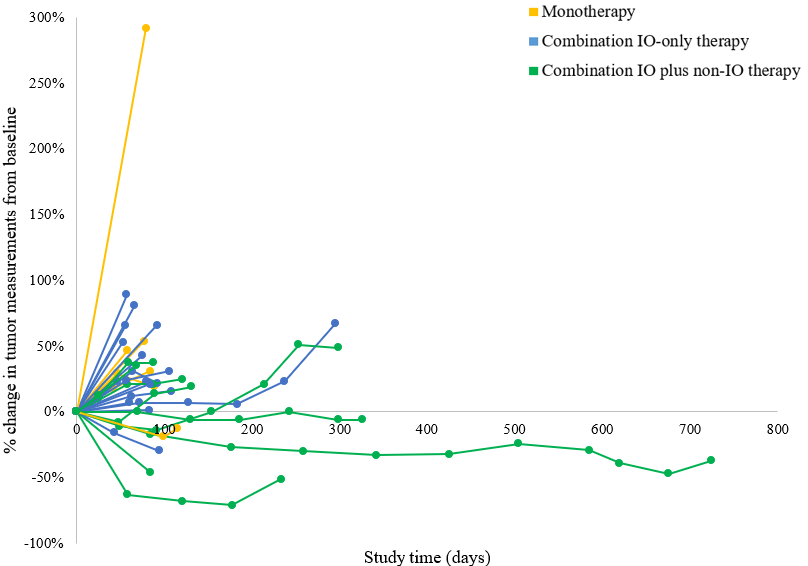
Figure 2. Tumor response across time. This spider plot demonstrates the tumor measurements from baseline using RECIST 1.1 criteria during the course of treatment with immunotherapy in 32 evaluable patients. IO = immuno-oncology.